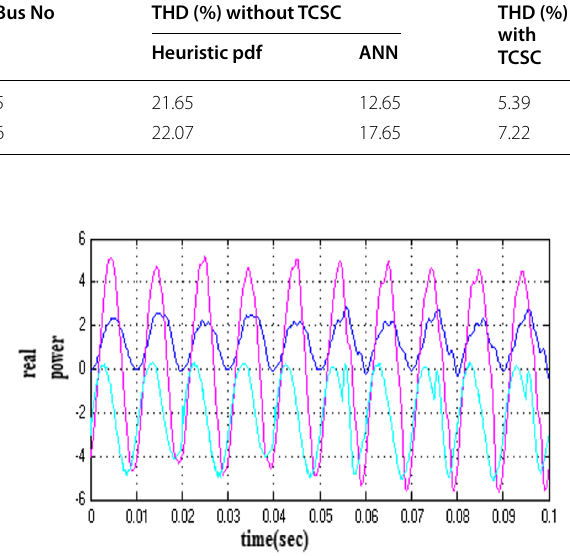
Fig. 9 Real power flow between buses 5 and 6 without TCSC for IEEE 9 bus